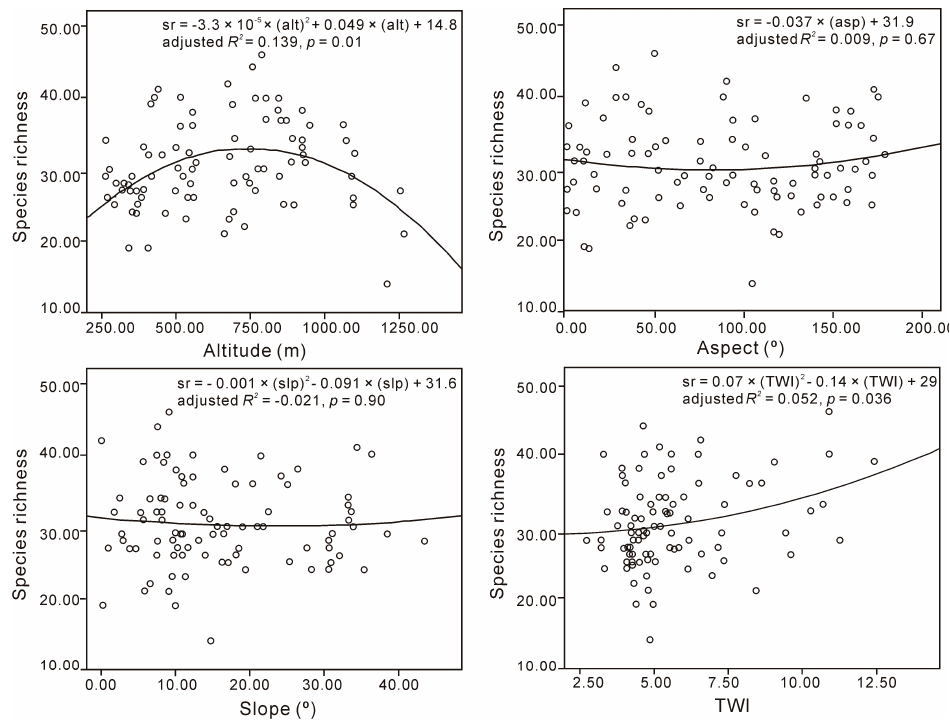
Figure 4. Estimated response curves of species richness (sr) to altitude (alt), aspect (asp), slope (slp) and the Topographical Wetness Index (TWI) based on the quadratic model.